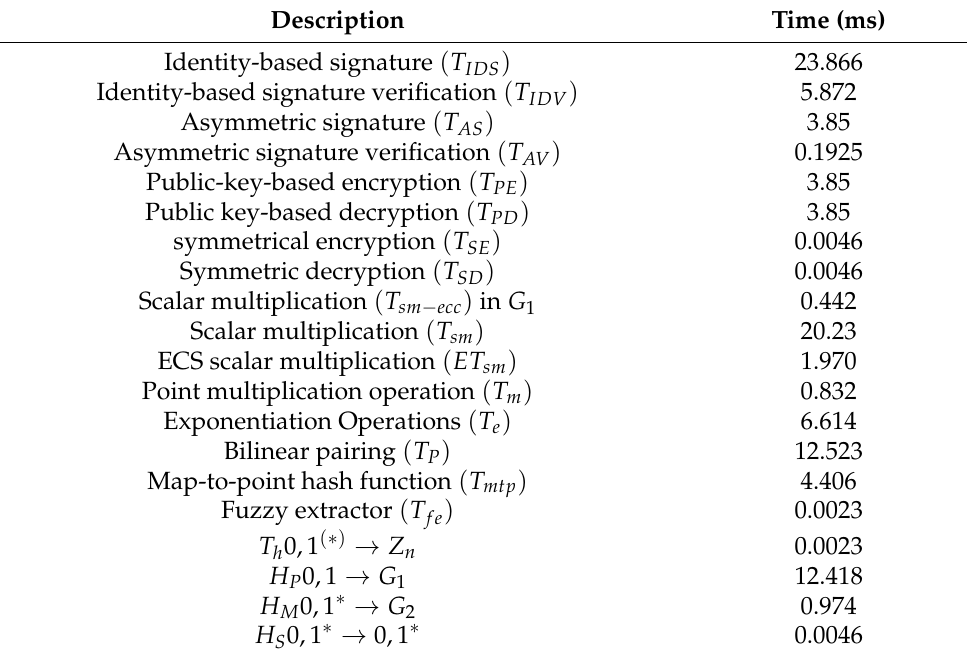
Table 6. Computational time